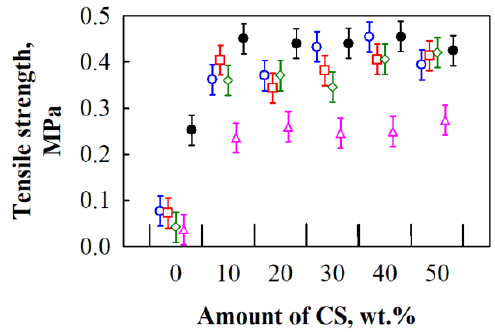
Figure 11. Impact of various amounts of CS and different HS fractions on tensile strength of BcB: ○ — 5/10 mm; □— 10/20 mm; ◊— 2.5/20 mm; ∆— 2.5/5 mm; ●— shredded HS.